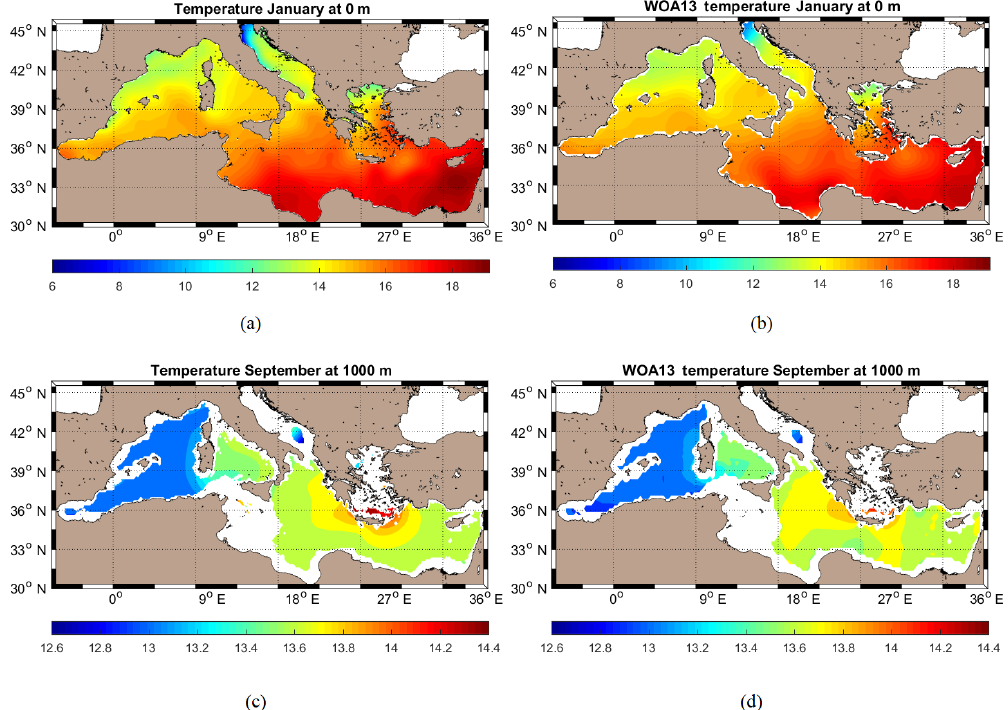
Figure 11. Comparison of atlas temperature (a, c) and WOA13 climatology (b, d) between January at 0m (a, b) and September at 1000m (c, d)